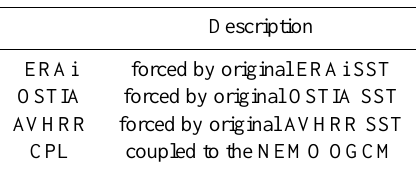
Table 2. Experiments performed with the ECMWF model for the MJO the winters